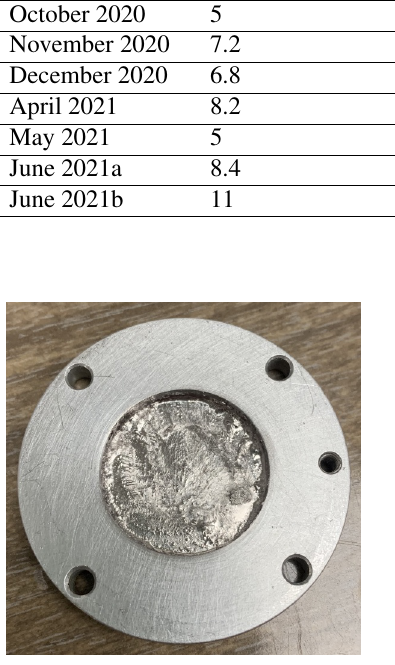
Figure 2. A bismuth target produced by melting bismuth pellets on a hot plate at 300 o C and spreading the bismuth using an ul- trasonic soldering iron. The surface is mostly smooth with some ridges and valleys with an average thickness of 66